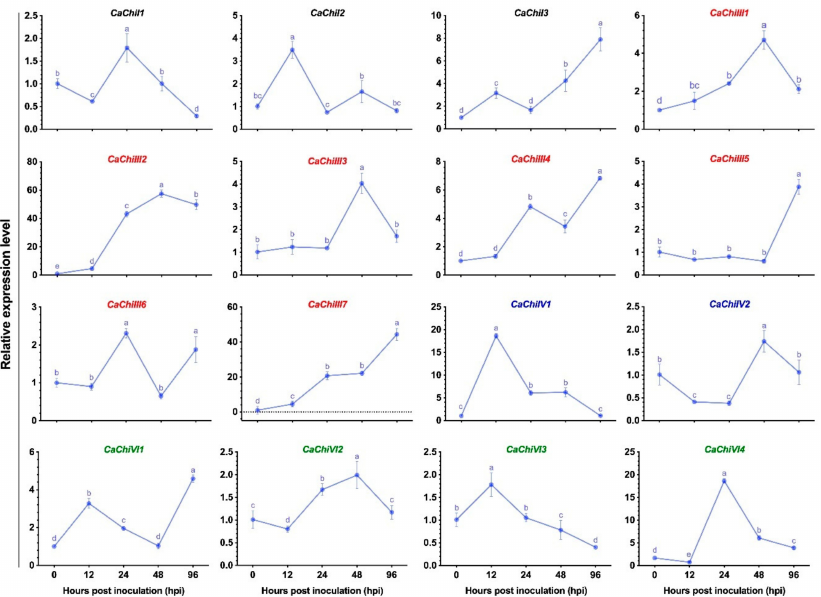
Figure 2. The transcript levels of chitin-binding protein family genes in response to C. gloeosporioides infection. Tissue samples were collected at different intervals (0, 12, 24, 48, and 96-h post-inoculation) and were examined by qRT-PCR. The colors represent classes: black: I, red: III, blue: IV, and green: VI. Here the mean values ± SDs of three replications are given. Lower case letters (a–e) on each line show significant differences at p ≤ 0.05 using the Duncan Multiple Range (DMR)